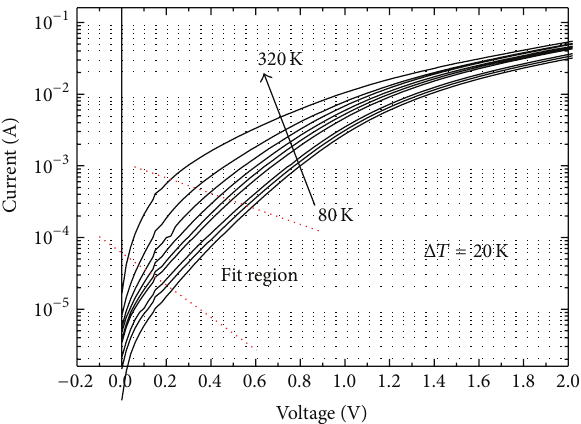
Figure 2: Experimental forward bias ln 𝐼 - 𝑉 characteristics of the Al/poly(4-vinyl phenol)/ p -GaAs structure at various temperatures.